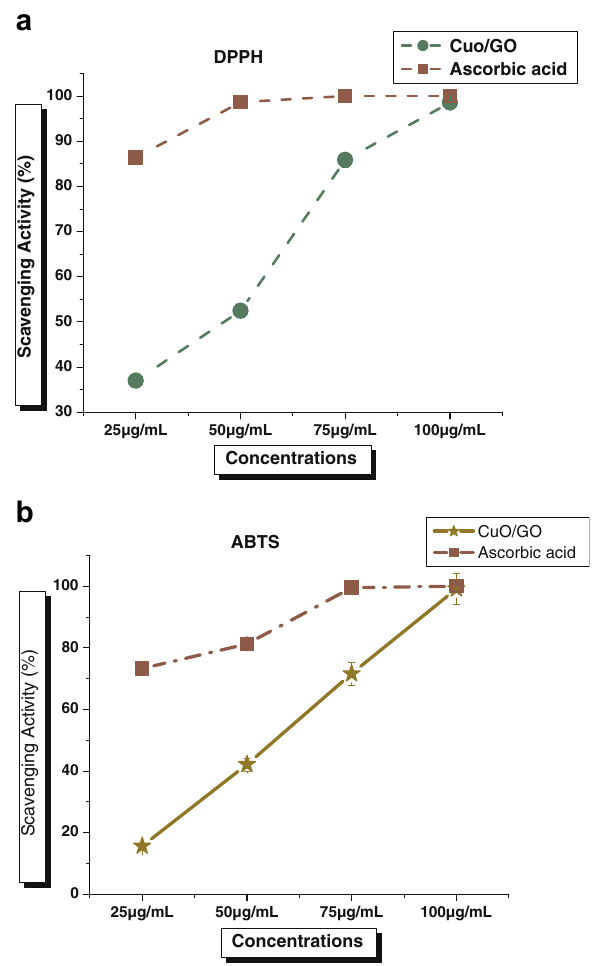
Fig. 7 Antioxidant activity of CuO/GO nanocomposite in terms of radical scavenging activity ( A ) DPPH and ( B ) ABTS. Error bar represents the standard deviation of the mean. * p ≤ 0.05